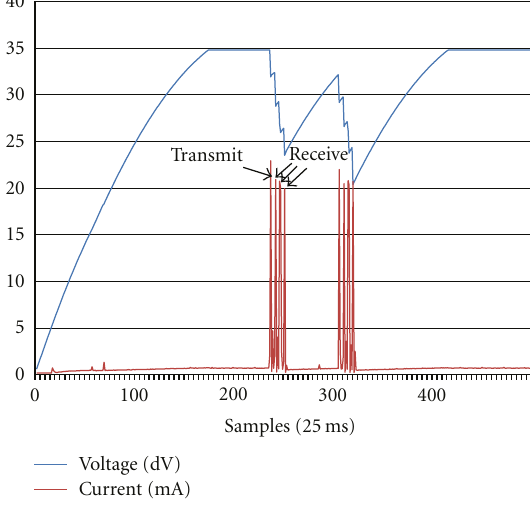
Figure 9: Energy-harvester emulation. Initially, there is no available energy. The application transmits one packet and listens three times. We see that the voltage drops during the radio activities and that it increases when more energy is harvested than is consumed (until the capacitor’s maximum is